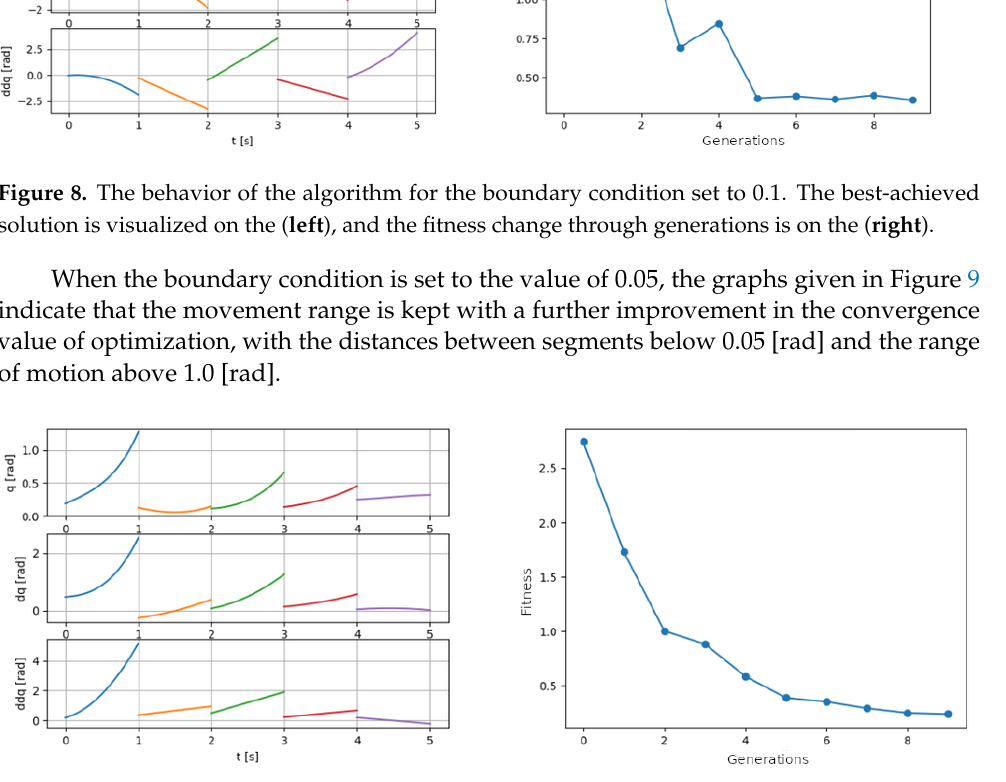
Figure 9. The behavior of the algorithm for the boundary condition set to 0.05. The best-achieved solution is visualized on the ( left ), and the fitness change through generations is on the ( right